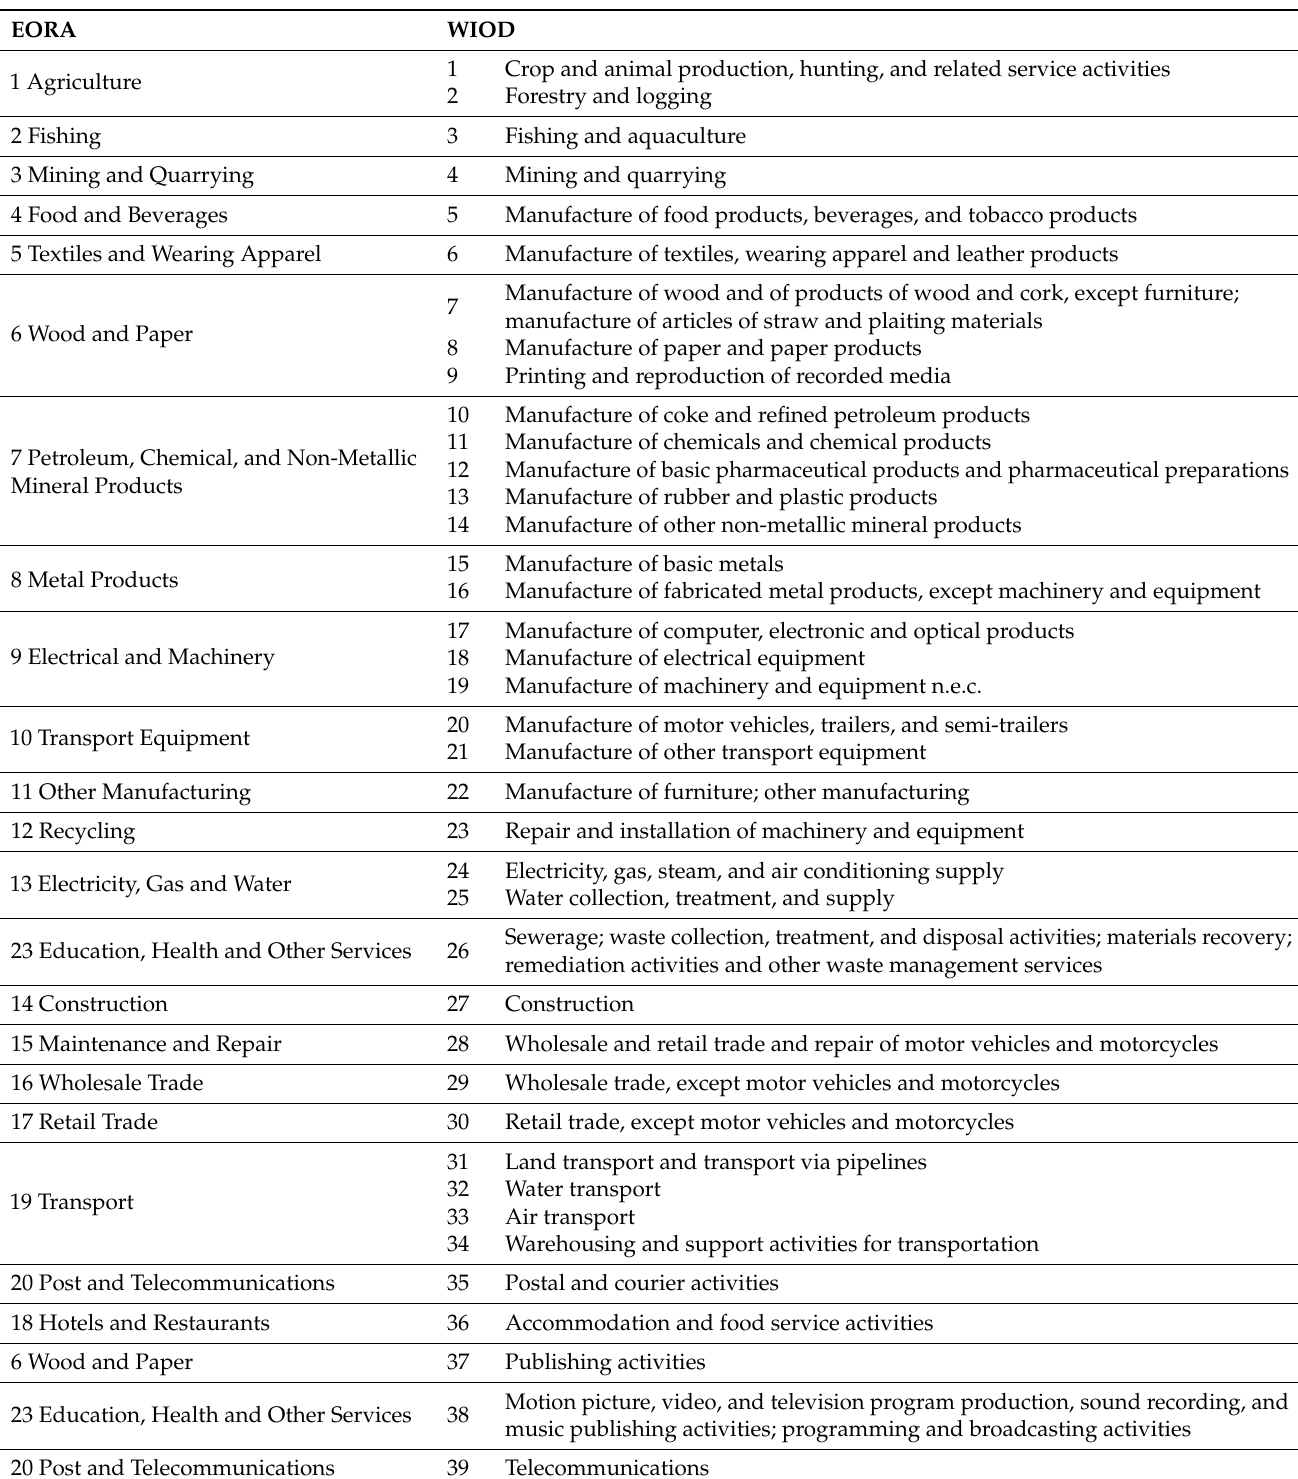
Table A2. EORA and WIOD departments transform the corresponding